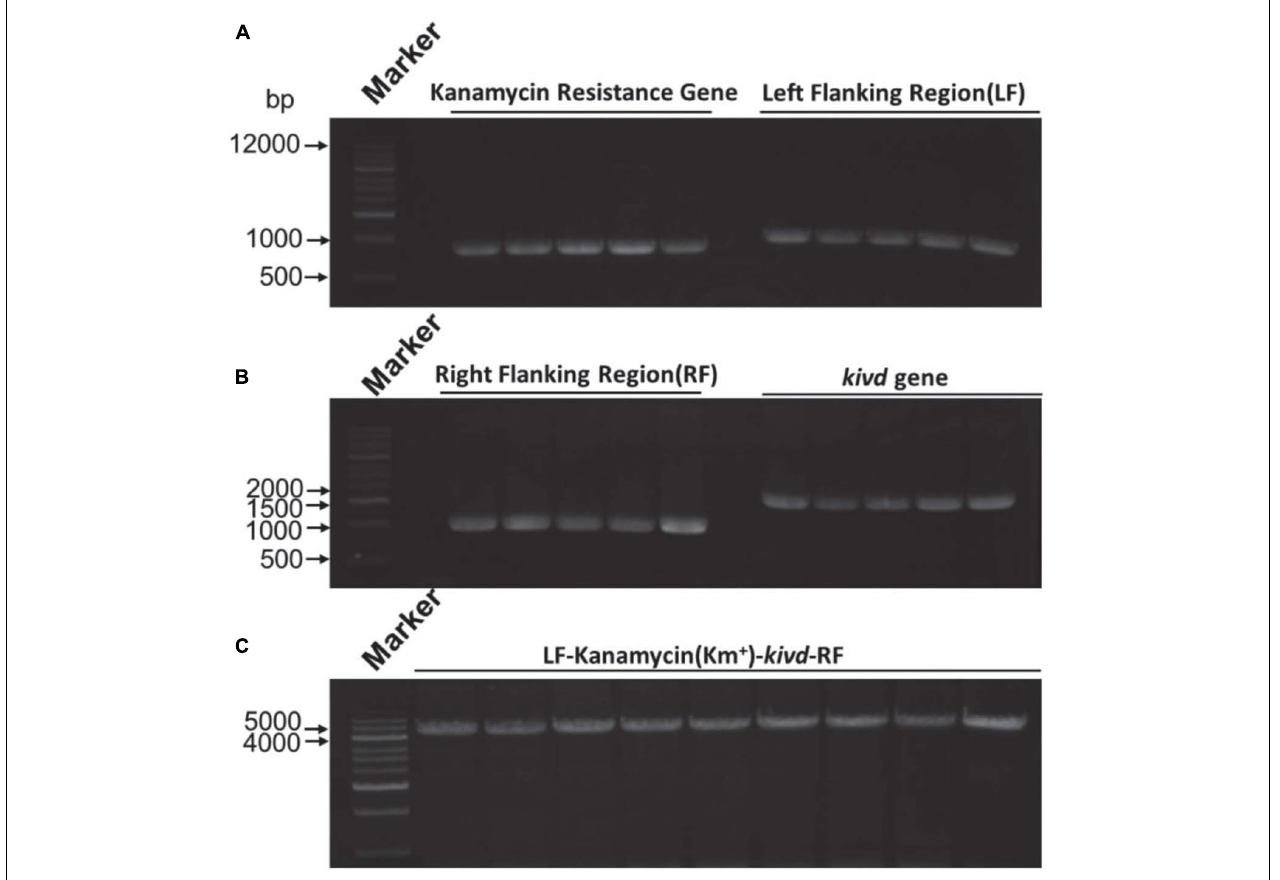
FIGURE 3 | Expression of the kivd gene in the fadE site of strain Methylomicrobium buryatense 5GB1S. (A) Agarose gel electrophoresis results of the kanamycin gene (816 bp) and the left flanking region (1,000 bp) for kivd expression. (B) Agarose gel electrophoresis results of the right flanking region (1,000 bp) for kivd expression of the kanamycin gene (1,000 bp) and the kivd gene (1,719 bp). (C) PCR confirmation of the expression complex of the kivd gene (LF + Km r + kivd + RF). A 1-kb marker was used. LF , left flanking region; RF , right flanking region; Km r , kanamycin.